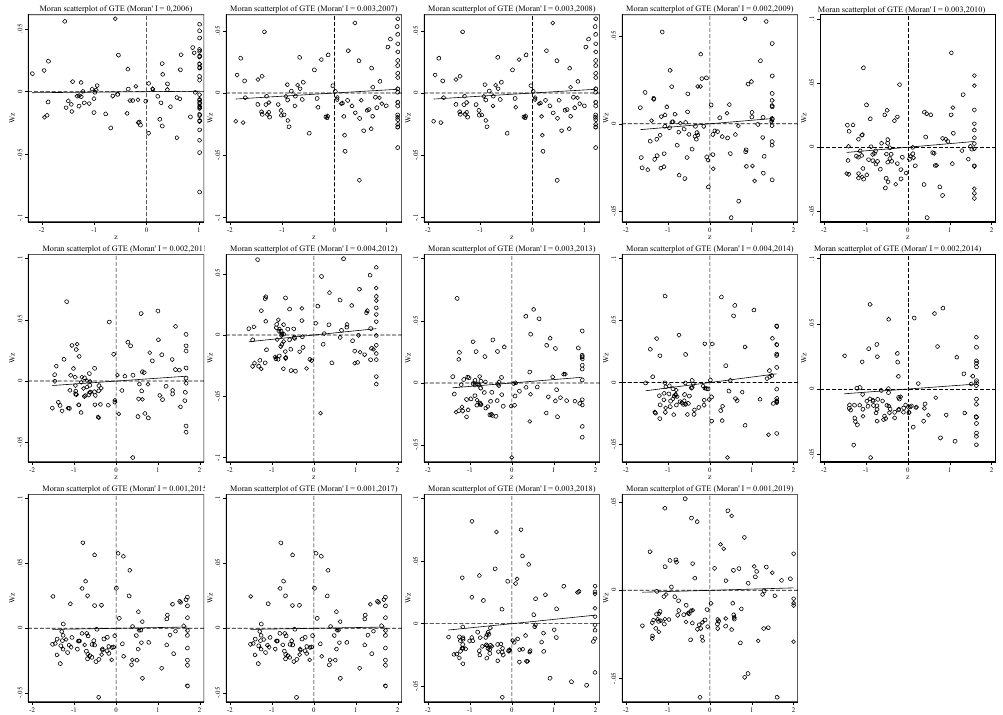
Figure 6. Distribution Change of GTE Moran’s I Scatter plot from 2006 to 2019.